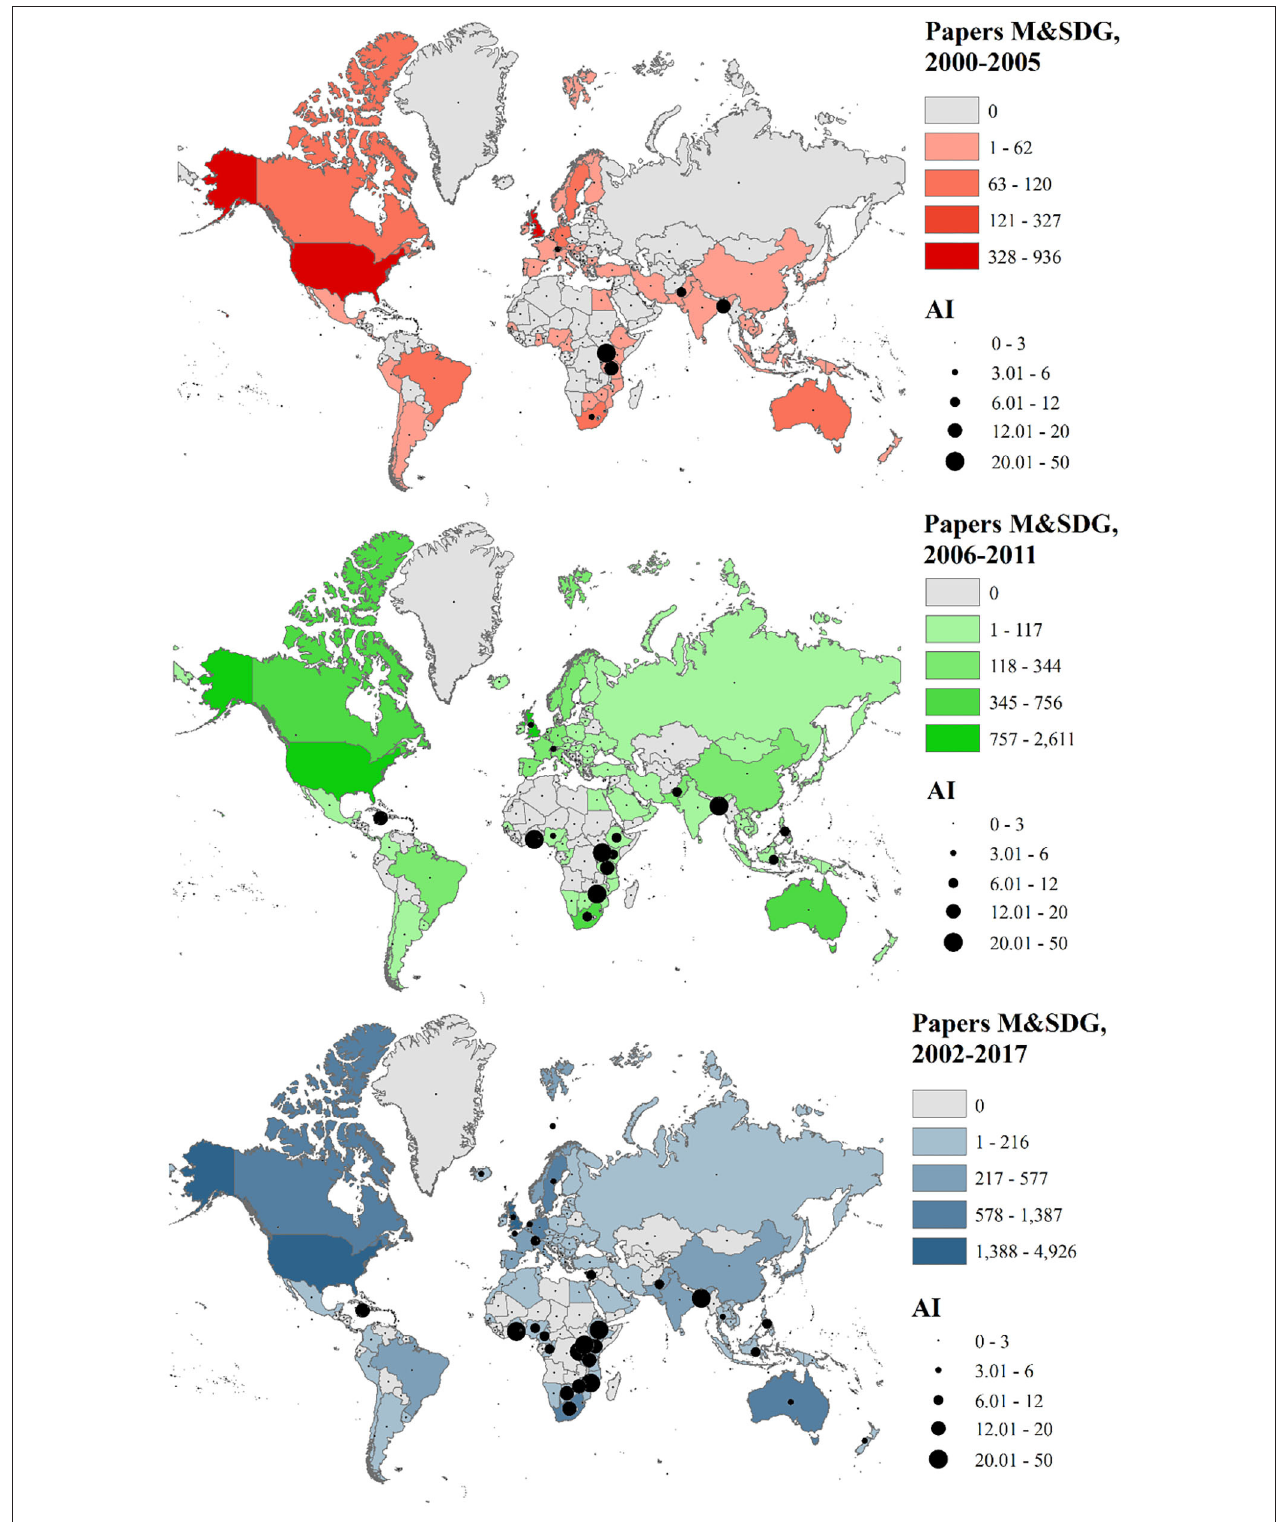
FIGURE 4 | Geographic distribution of scientific publications and AI (countries with > 20 publications).